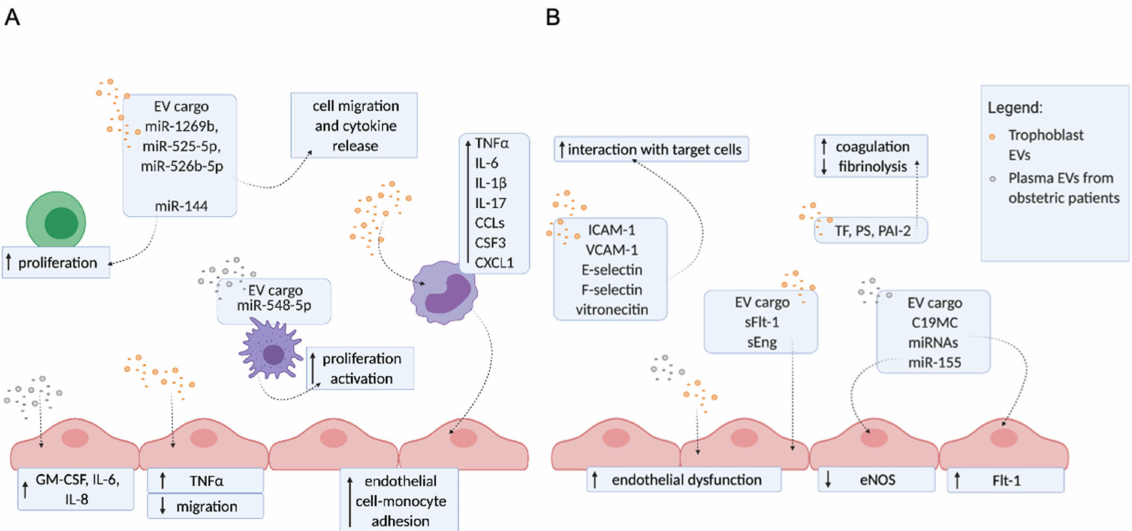
Figure 2. EVs isolated from plasma of patients with obstetric complications or derived from cultured trophoblasts enhance inflammation, coagulation, and endothelial dysfunction. Schematic presentation of in vitro mechanisms focusing on vascular function, inflammation, and thrombosis. ( A ) Mechanisms contributing to enhanced inflammation. EVs from trophoblasts (orange spots) carry miRNAs (miR-1269b, miR-525-5p, and miR-526b-5p) that are associated with cell migration and cytokine production in target cells and miR-144 involved in T-cell activation and proliferation. Furthermore, trophoblast EVs induce cytokine production in monocytes suppressing their chemotactic activity and motility. EVs isolated from plasma of patients with obstetric complications (grey spots) carry miR-548-5p, which was found to modulate the proliferation and activation of macrophages. EVs were also shown to interact with endothelial cells and influence the release of pro- inflammatory molecules and decrease the migration of these cells. ( B ) Mechanisms contributing to endothelial dysfunction and coagulation. EVs isolated from trophoblasts carry different adhesion molecules on their surface, potentially increasing the interactions of these EVs with target cells. In addition, on their surface, EVs carry tissue factor (TF), phosphatidylserine (PS), and plasminogen activator inhibitor-2 (PAI-2), molecules involved in increased coagulation and decreased fibrinolysis. EVs directly interact with endothelial cells causing the endothelial dysfunction, partially by the transfer of their cargo, fms-like tyrosine kinase-1 (sFlt-1) and endoglin (sEng). By the transfer of their miRNas, trophoblast EVs influence the expression levels of eNOS (miR-155) and modulate the expression of several other genes, including Flt-1, involved in endothelial dysfunction (C19MC miRNAs). CCLs: chemokine (C-C motif) ligands; CSF3: colony stimulating factor 3;